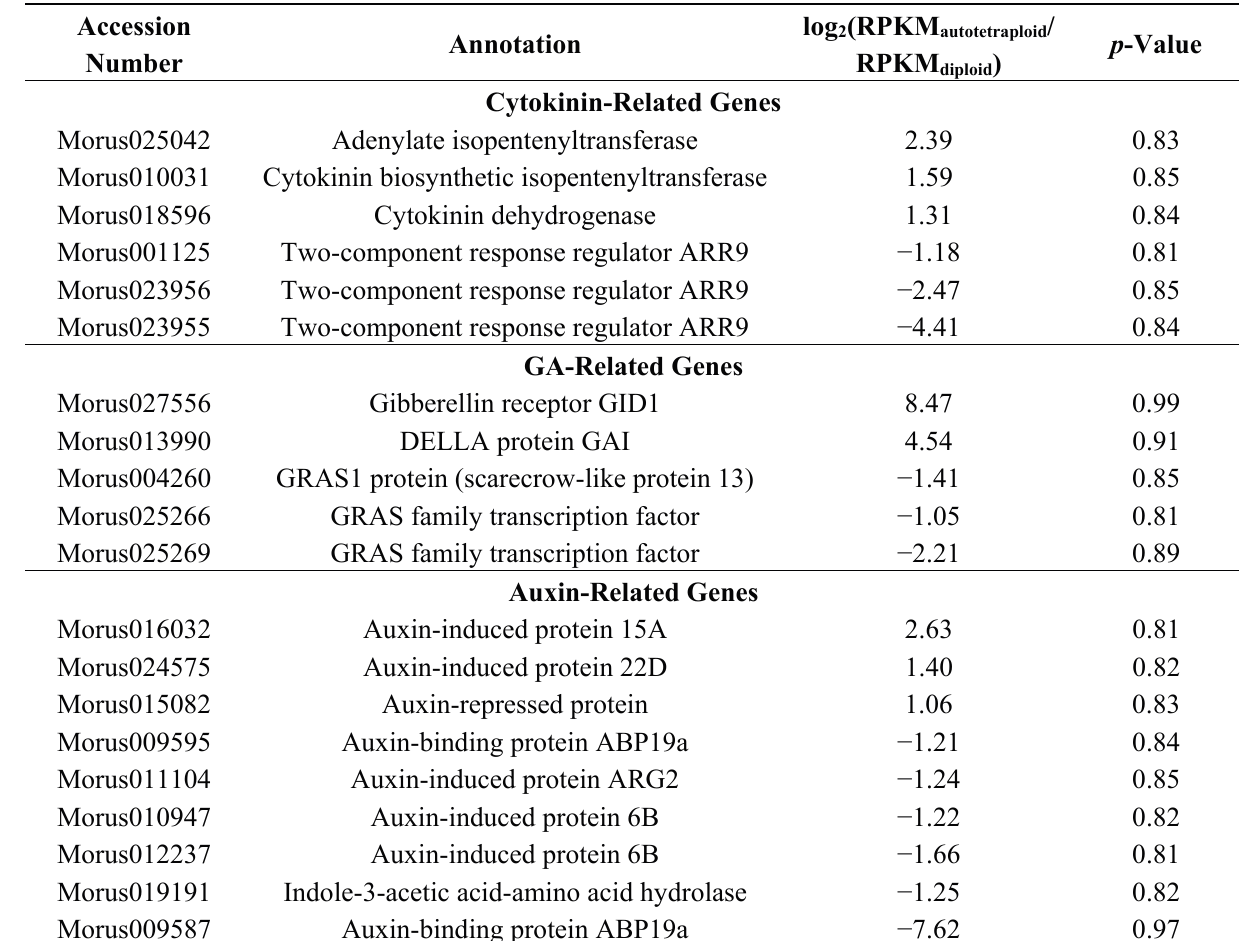
Table 3. Differentially expressed genes involved in the biosynthesis and signal transduction of plant hormones. The fold change of each regulated gene is reported as log 2 , and